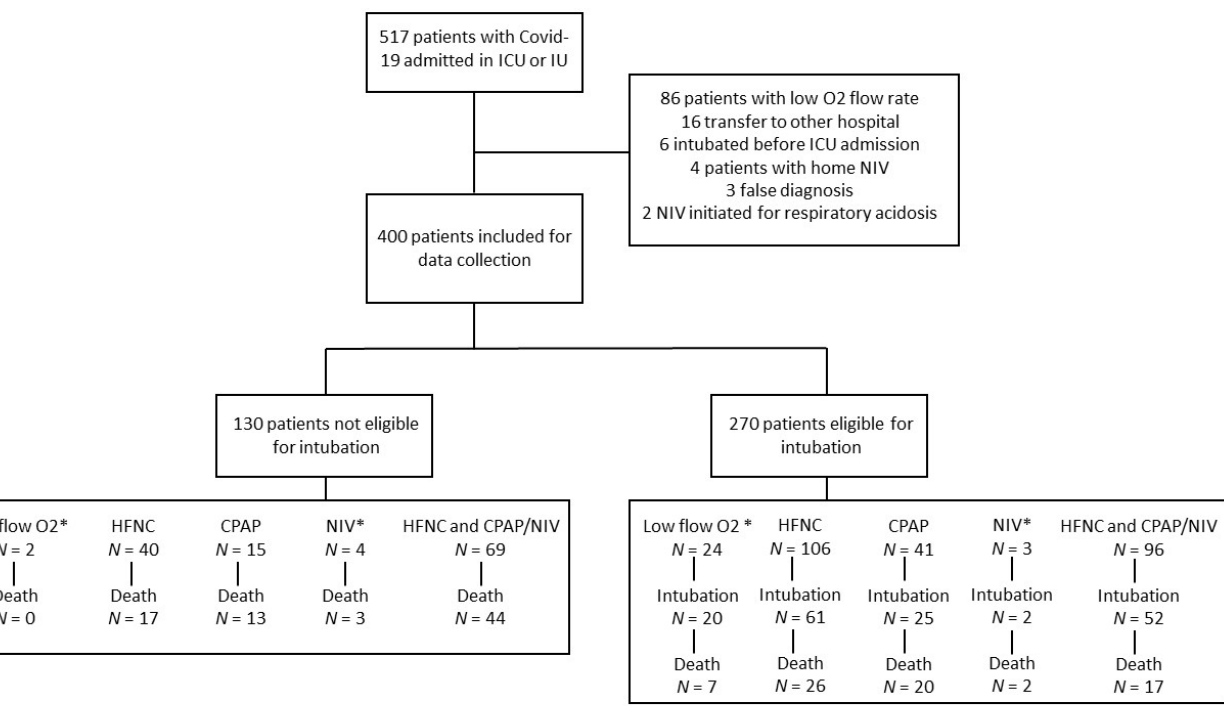
Figure 1. Flow chart. * Low flow O 2 is defined by non-rebreather mask with O 2 flow at least at 10 L/min. NIV: Bi-level NIV. Table 1. Population